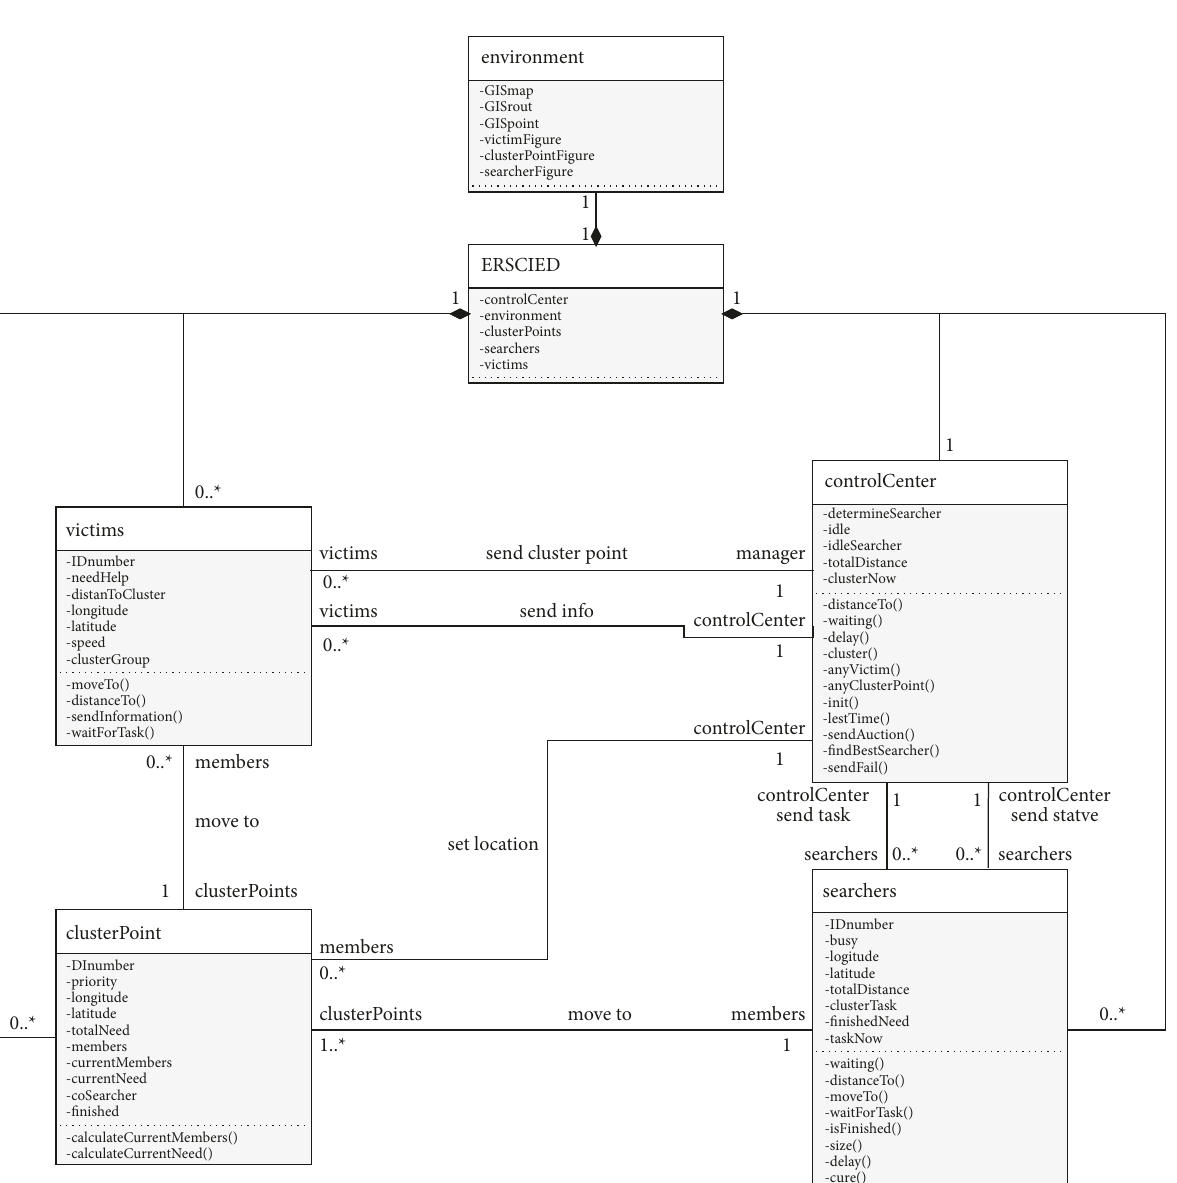
Figure 7: The ERSCIED agent class